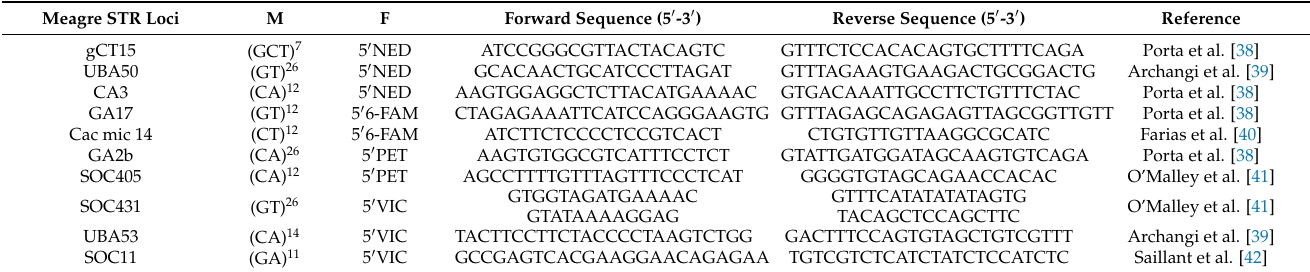
Table 1. Microsatellite panel of meagre.